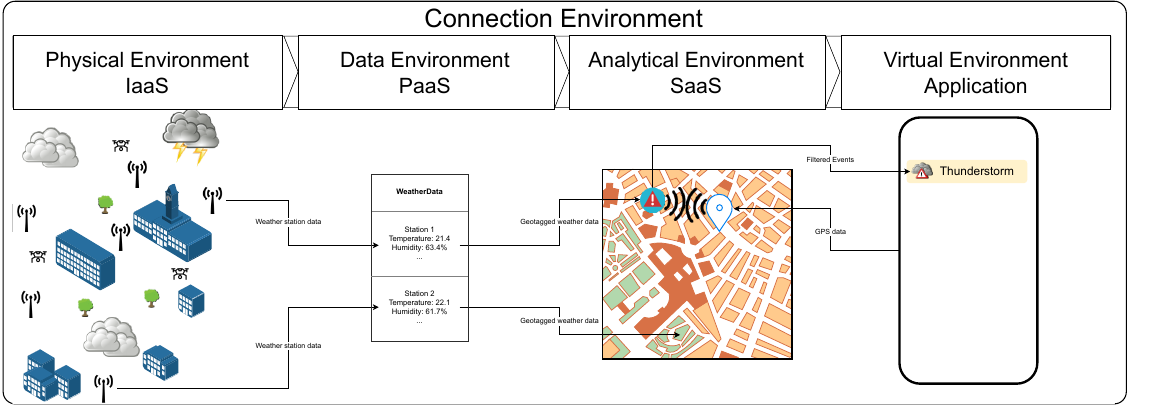
Figure 11. Mapping of the “as a Service” paradigm to the components of a Digital Twin and the weather services example. This example application is an alert for a nearby weather event. Presented from left to right, the PT forms the Physical Environment of the DT and is captured by local sensors and networks and remote sensing as IaaS. The Data Environment of the DT serves as a PaaS. The Analytical Environment of the DT models the weather and calculates the proximity to the predicted event as a SaaS. The Virtual Environment is implemented as a smartphone application that provides an alert on an abstract Dashboard. The Connection Environment spans across all services and environments providing an API that allows for one environment to be replaced by another. This makes the DT both modular and composable. Generated with